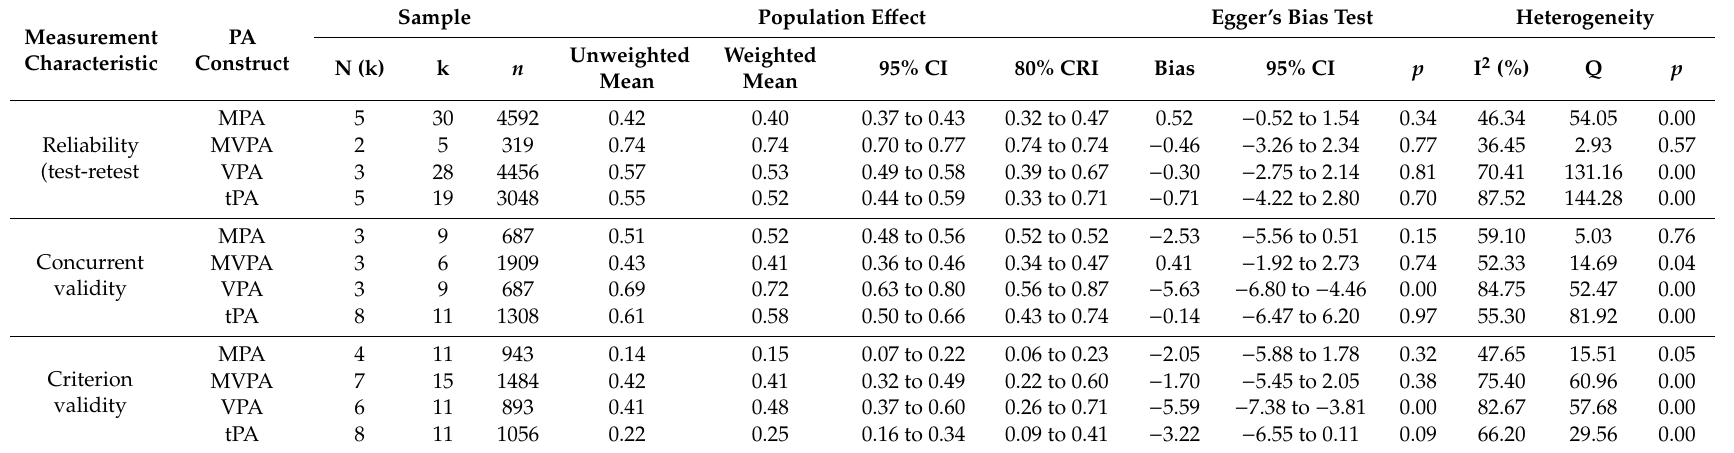
Table 3. Summary results for test-retest reliability, concurrent validity and criterion validity across all included studies stratified by PA